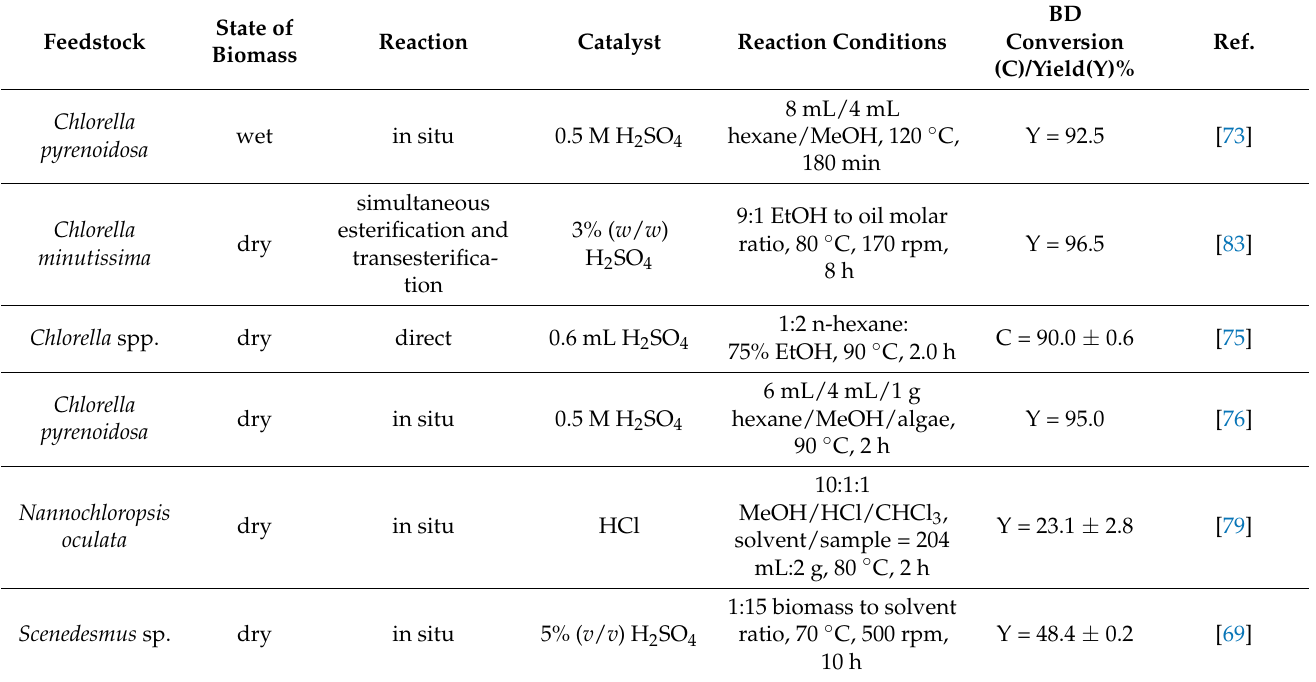
Table 3. Summary of homogeneous acid catalysts studied for the transesterification of microalgae